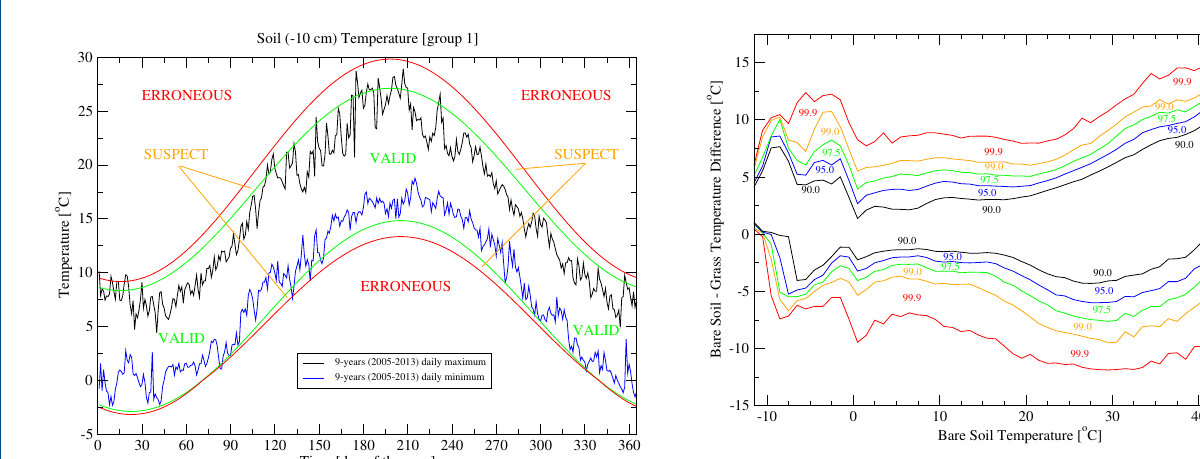
Figure 3. Example of annual variation expectancy envelopes used in the Global Daily QC Limits Consistency test. Illustrated limits apply to the daily mean soil temperature recorded at − 10cm for stations of climate zone 1 (see Table 1)